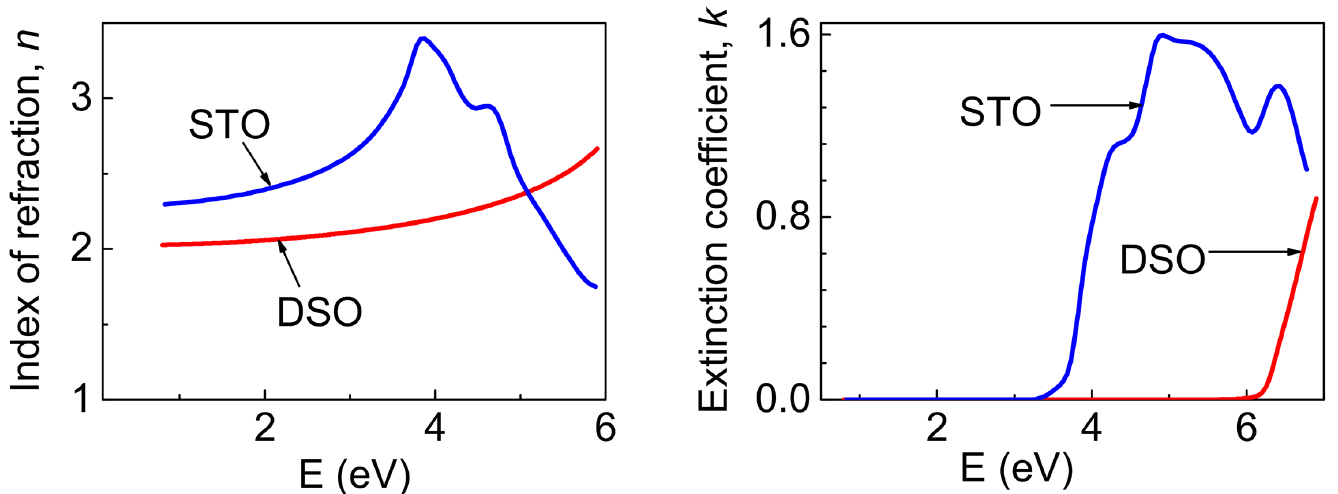
Fig 1. Index of refraction (a) and Extinction coefficient (b) of SrTiO 3 and DyScO 3 substrates.